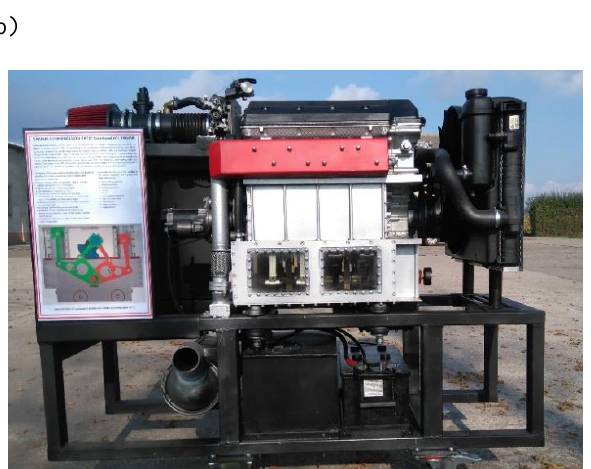
Fig. 2. Kinematic diagram of a) classic linkage, b) first conception of the rocker engine